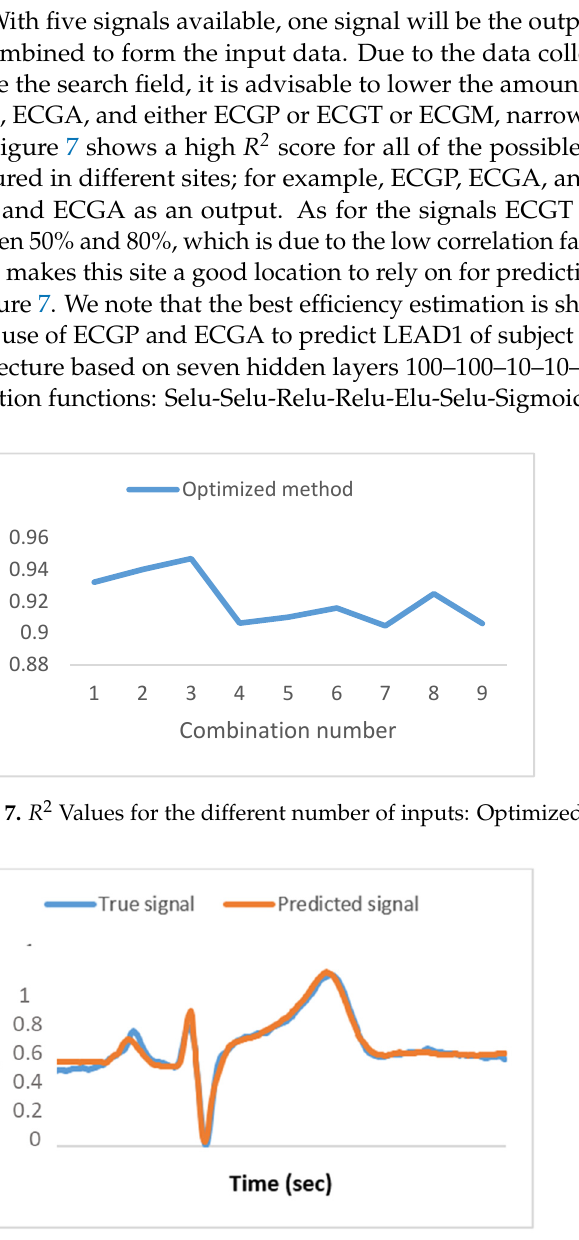
Figure 8. Response of the proposed method: ECG prediction plot.